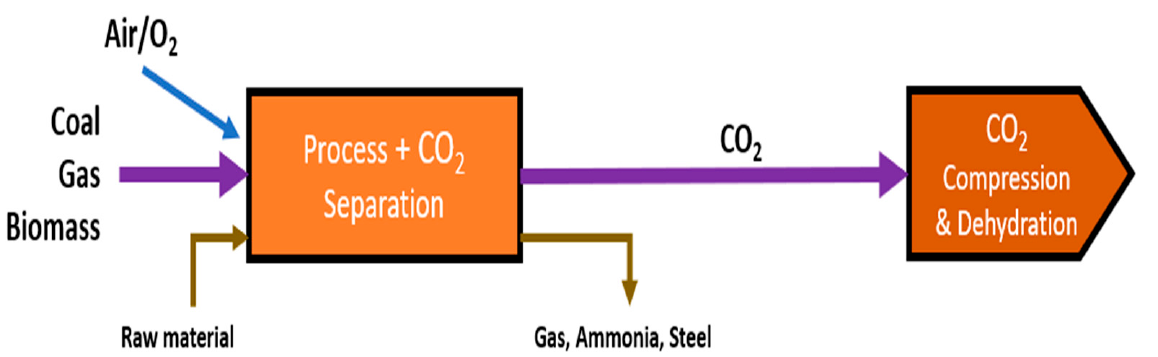
Figure 1. CO 2 capture systems in industrial processes (adapted from BP).